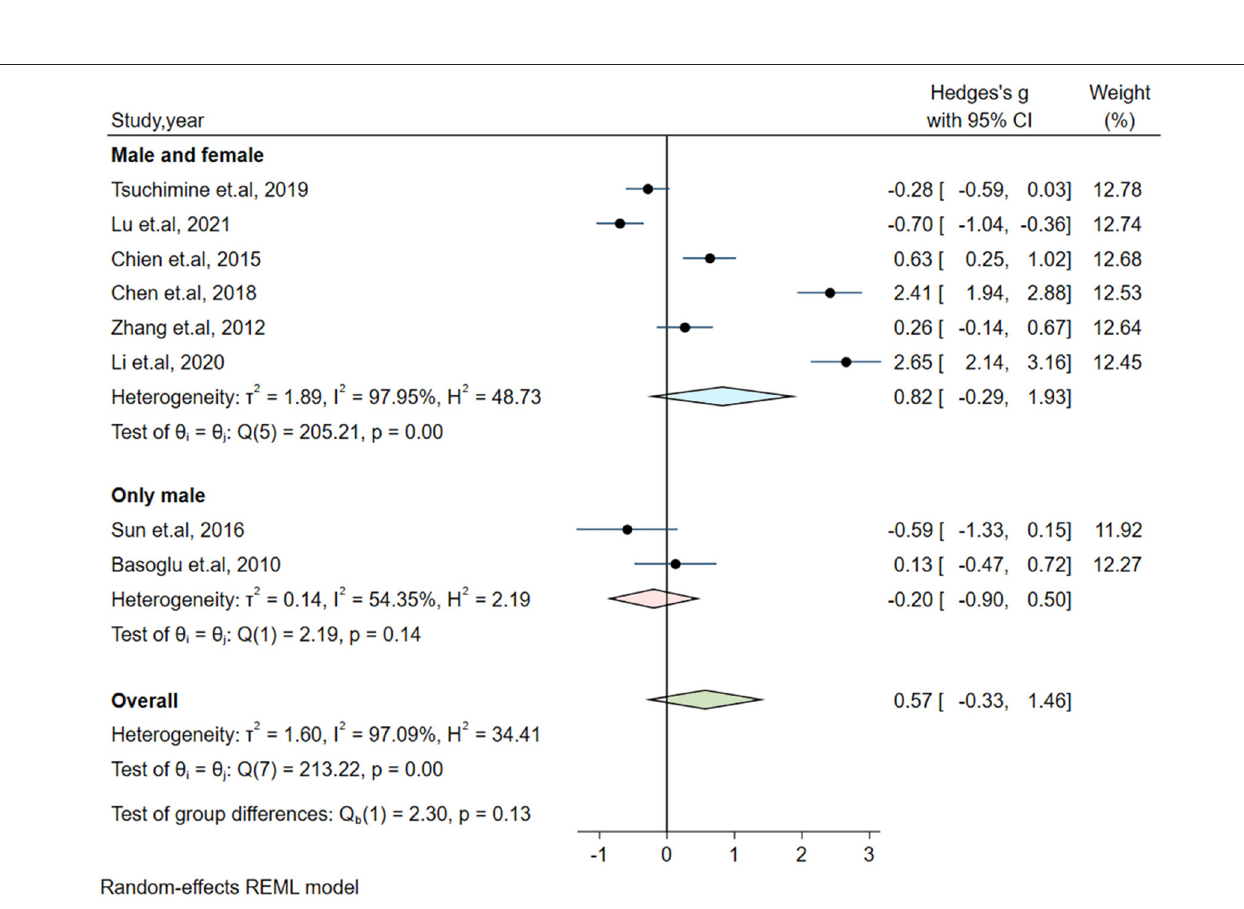
Frontiers in Psychiatry |